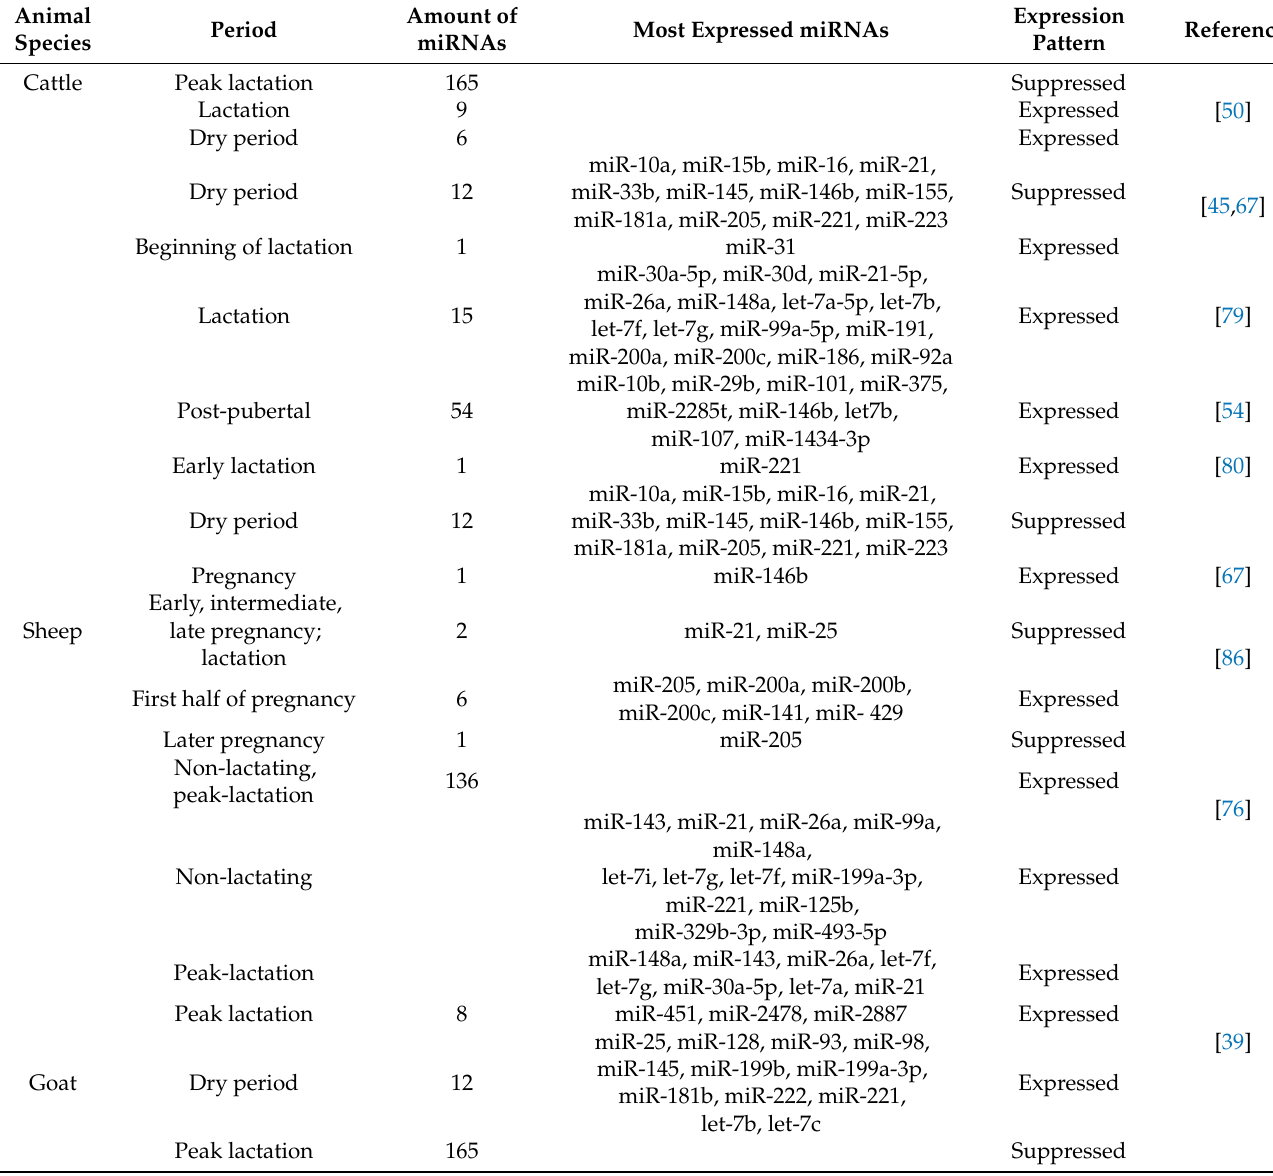
Table 4. A brief summary of the temporal patterns of miRNAs expression depending on the period of mammary gland